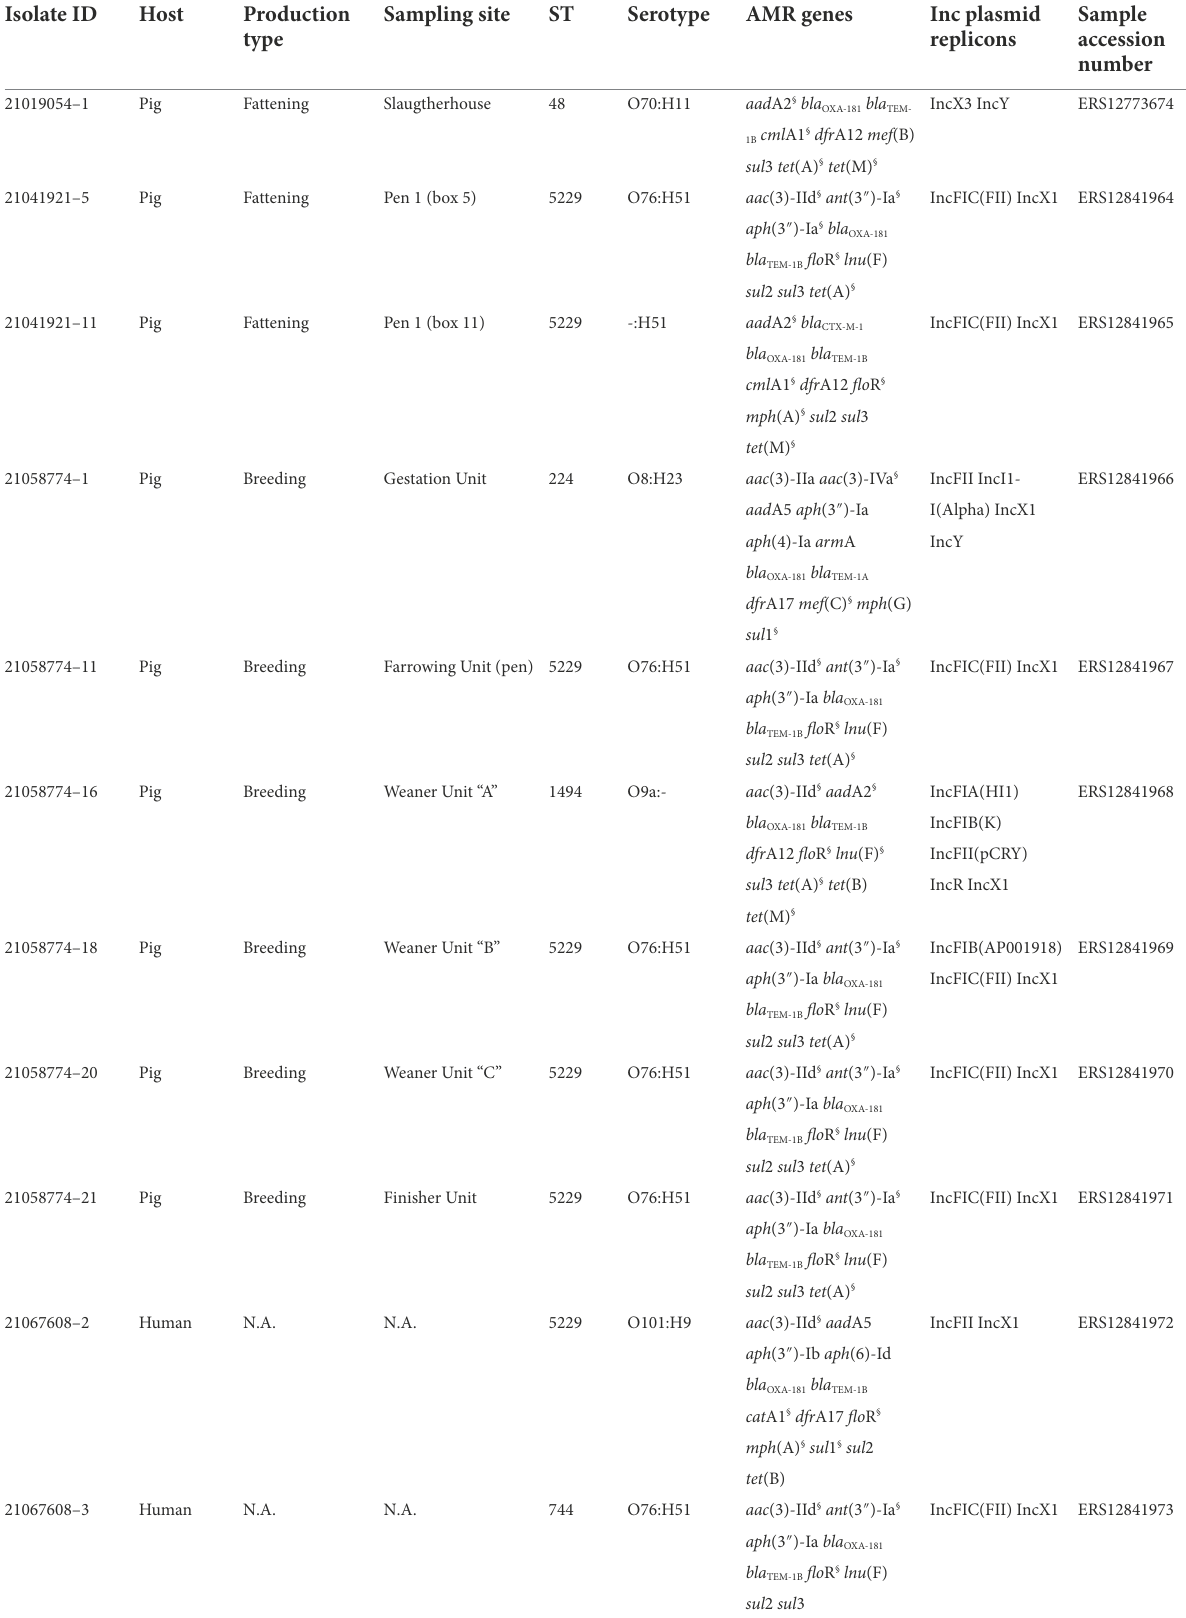
TABLE 3 Metadata and genomic characteristics of the OXA-181 producing Escherichia coli obtained from the samples collected in the context of the tracing- back activities after the first OXA-181-producing E. coli isolate detection. Isolate